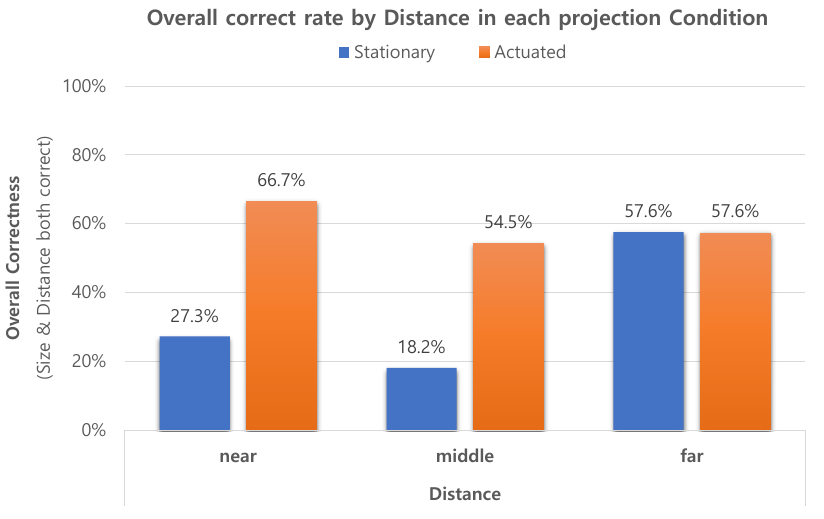
Figure 9. The ratios of correct ratings, categorized by distance in each condition, stationary and actuated , and their total